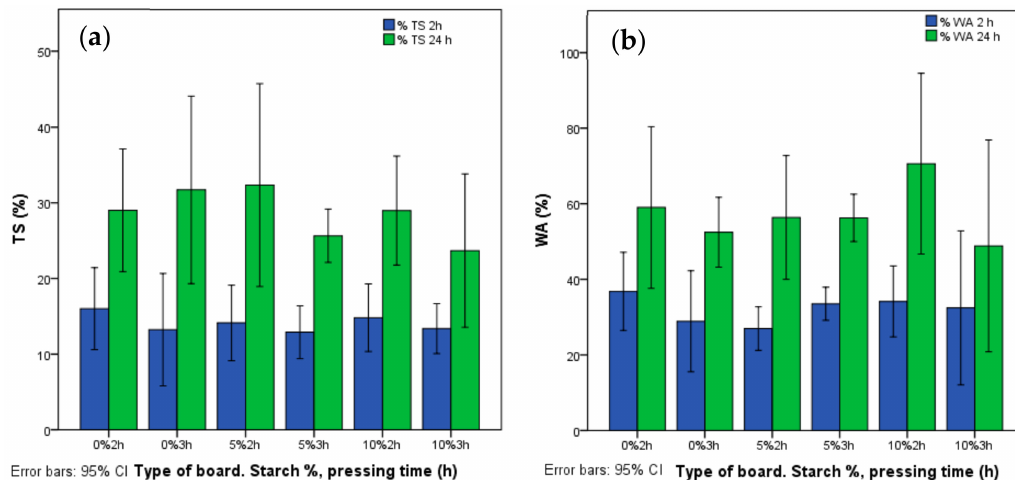
Figure 5. Percentage of thickness swelling ( a ) and water absorption ( b ) after 2 and 24